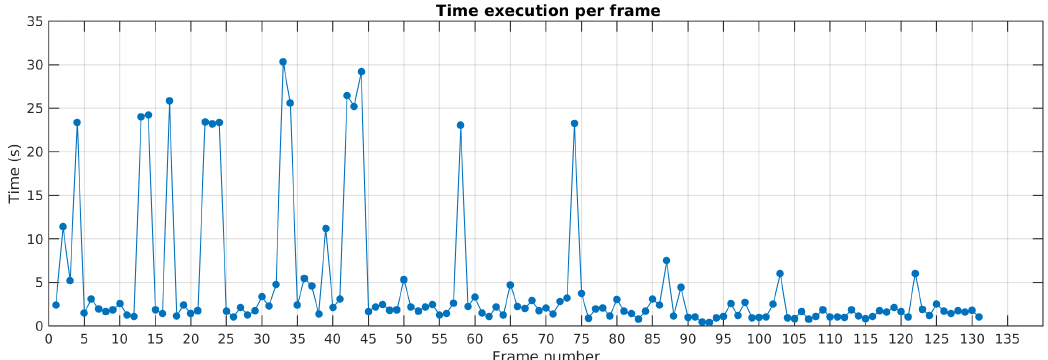
Figure 24. Execution time along the sequence for Scene